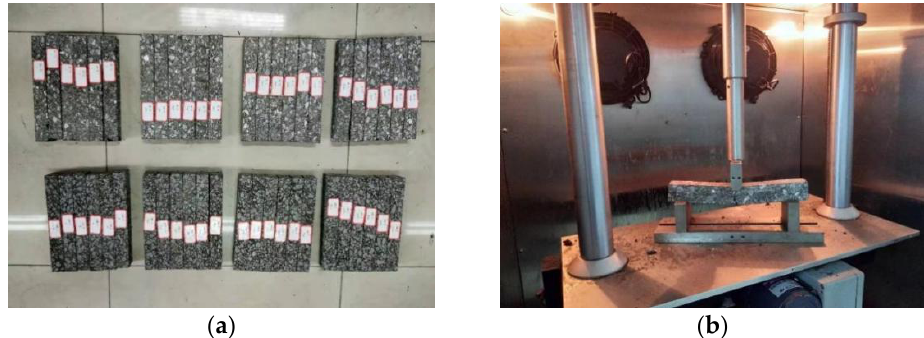
Figure 3. Low temperature trabecular bending test: ( a ) forming trabecular specimen; ( b ) test photo.